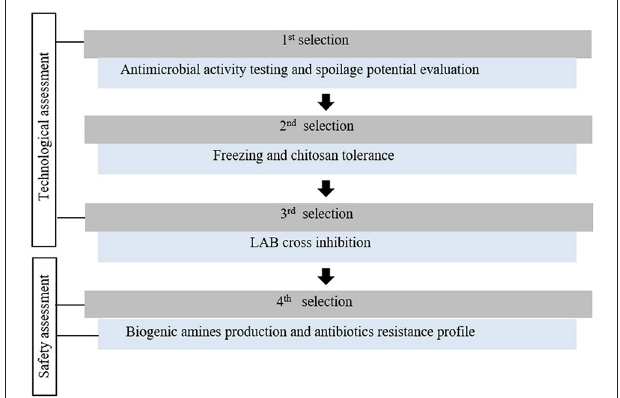
FIGURE 1 | Protective cultures selection strategy for seafood products microbial safety and quality